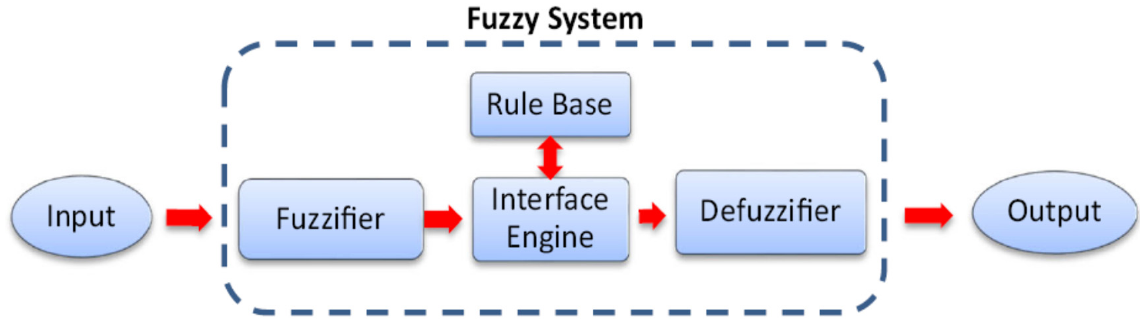
Figure 4. Components of the fuzzy system.